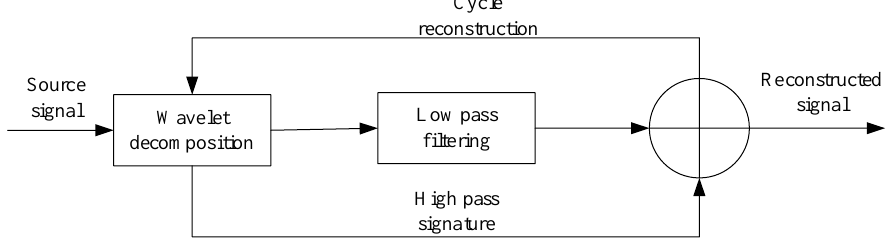
Figure 3. Principle of adaptive wavelet decomposition and recombination.